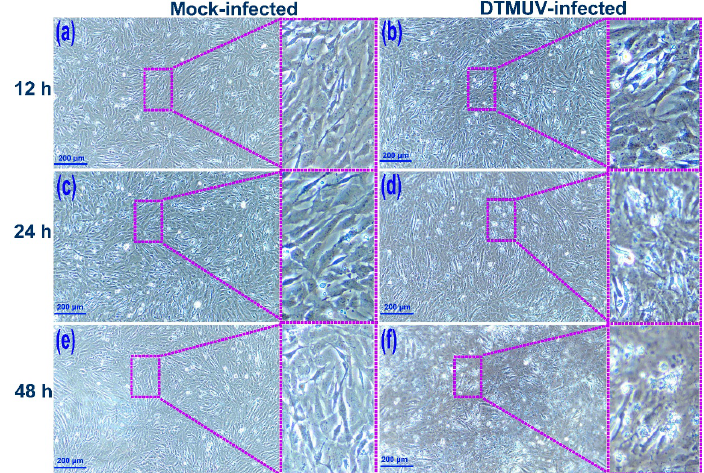
Figure 1. Cytopathic effects following infection of duck embryo fibroblasts with duck Tembusu virus at 12, 24, and 48 h post-infection. ( a , c , e ) no CPEs were observed in mock-infected cells. ( b , d , f ) the CPEs (e.g., cell shrinkage, rounding, and suspension) were found in cells infected with DTMUV. The blue scale bar represents 200 µ m.